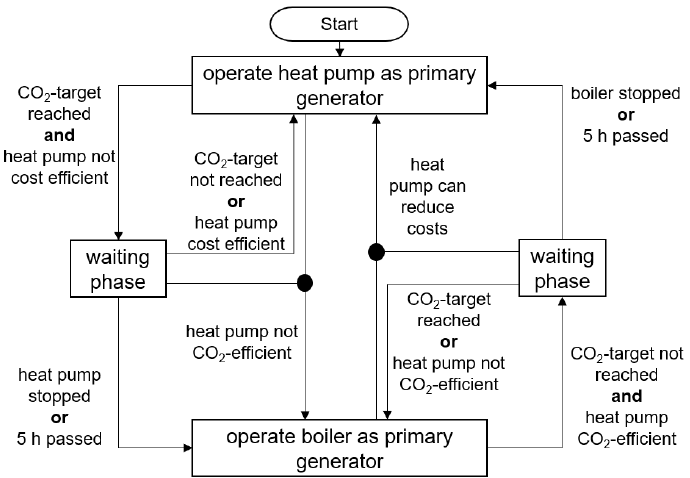
Figure 11. Algorithm scheme to reach defined specific CO 2